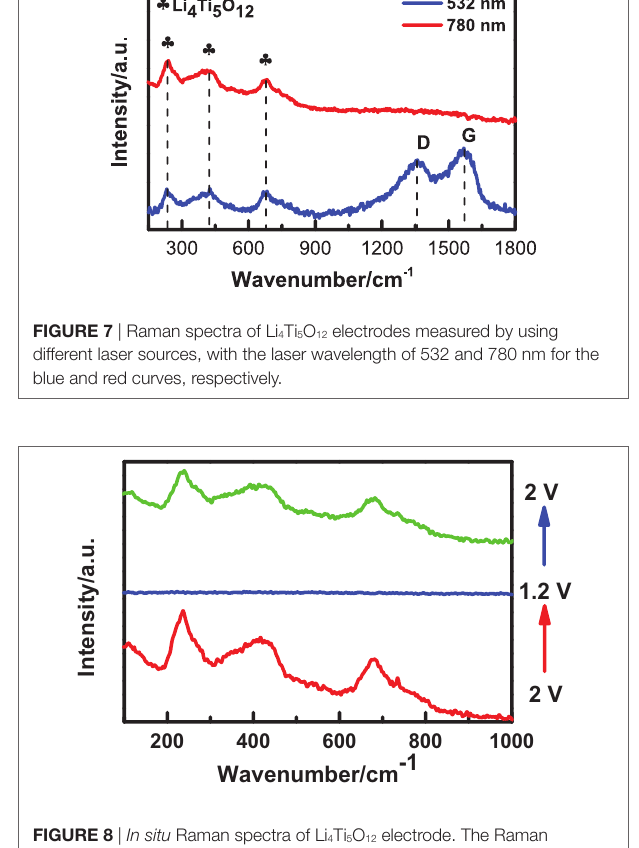
FigUre 8 | In situ Raman spectra of Li 4 Ti 5 O 12 electrode. The Raman spectrum evolved as the charged electrode (bottom red curve) was discharged to 1.2 V (middle blue curve) and then charged to 2.0 V (top green curve).